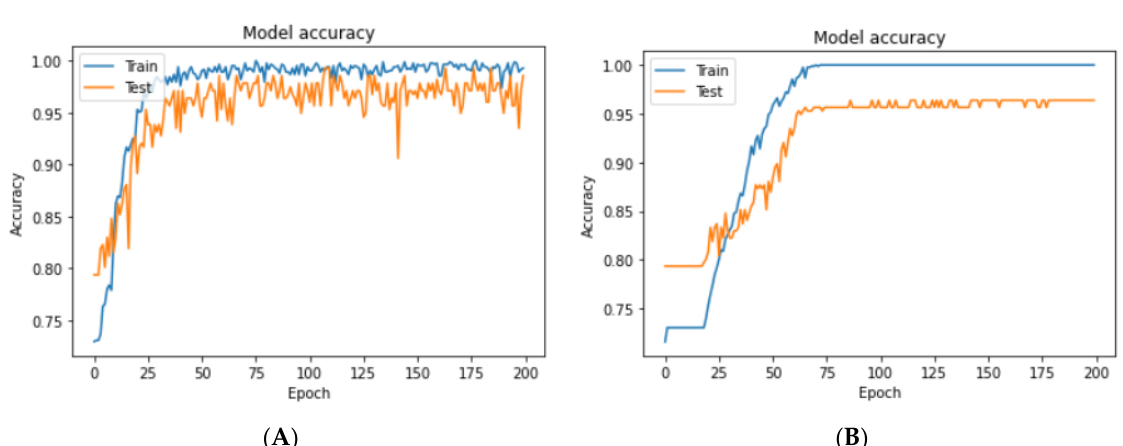
Figure 7. The accuracy plots of training and test datasets. ( A ) Training and test accuracy of the customized CNN with RMSprop optimizer and a learning rate of 0.001. ( B ) Training and test accuracy of the standard CNN with Adam optimizer and a learning rate of 0.0001.